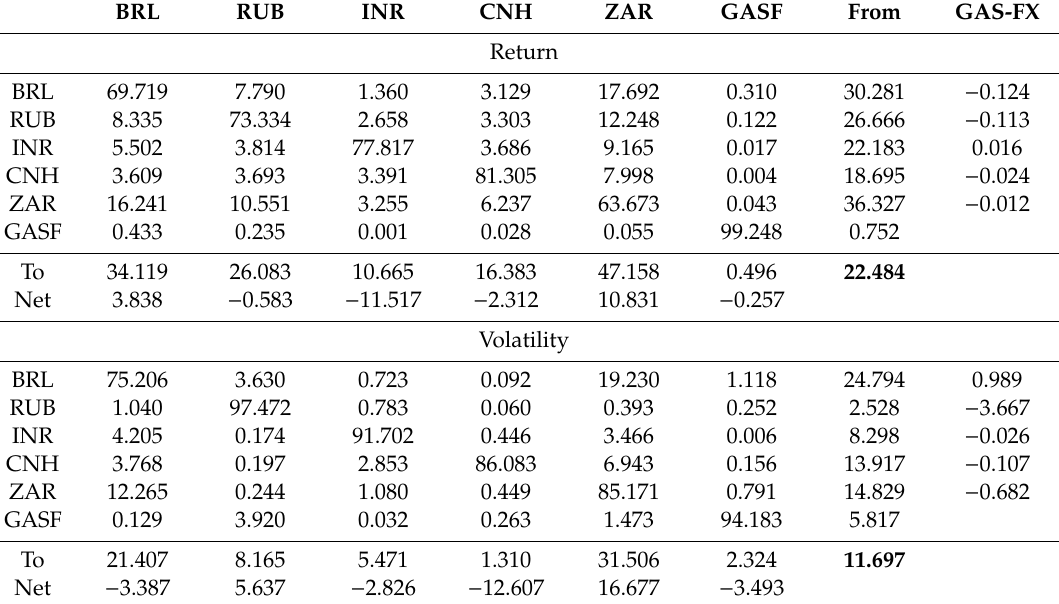
Table 6. Connectedness among the natural gas future price and BRICS’s exchange rates.